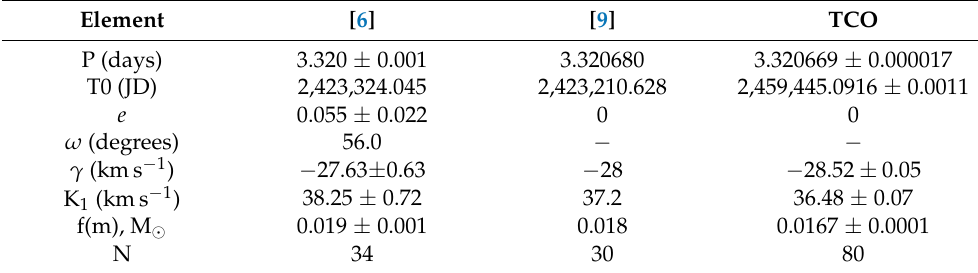
Table 2. Orbital elements derived for φ Aquilae (HR 7610).